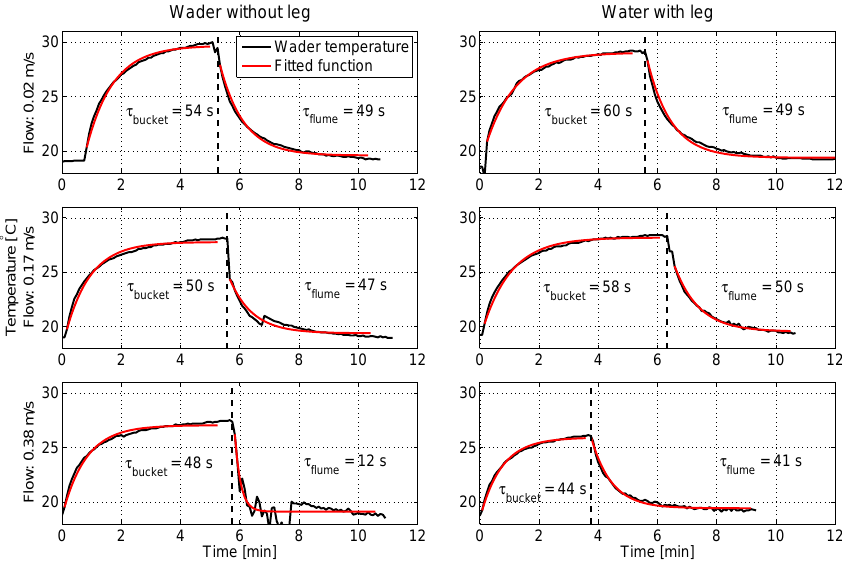
Figure 4. Results of the flume experiment. The left column of graphs shows the results when no leg is present in the wader; the right column shows when a leg is present. The temperature measured by the waders is shown in black. The fit of Eq. (2) is shown in red. The fitted time constants for the heating of the wader in the bucket τ bucket , and for the cooling of the wader in the flume τ flume are printed in the graphs. The dashed line indicates when the wader was put from the bucket into the flume. The high turbulence in the situation with high flow (0.38ms − 1 ) and no leg made it hard to keep the boot at a constant location in the stream, causing erratic measurements. For identical flow velocity (0.02ms − 1 ), the situation with and without a leg in the wader converges to identical temperatures, indicating a neglectable effect of the human body temperature. The time constant is large compared to state-of-the-art temperature sensors and only decreases slightly with increased flow.